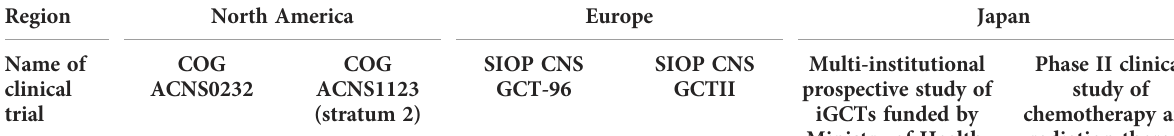
TABLE 2 Representative clinical trials for germinomas across